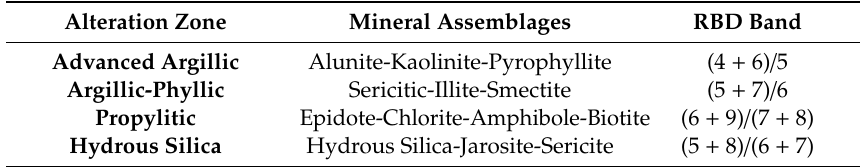
Table 2. The RBD indices applied for hydrothermal alteration mapping in the study area using ASTER